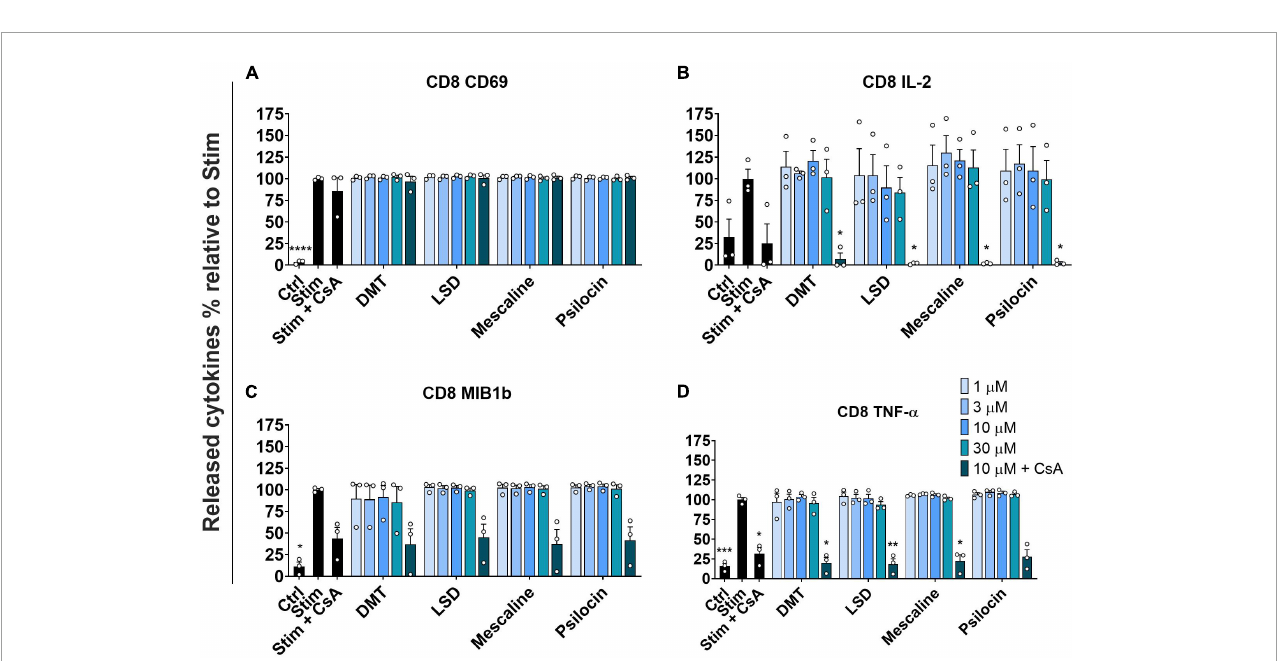
FIGURE2 Influence of classic psychedelics on (A) the activation (CD69) and function/mediator release in form of (B) IL-2 release, (C) CC-chemokine ligand 4 (MIB1b) release, and (D) TNF- α release of primary human CD8 + T cells. PBMCs were stimulated with anti-human CD3 and anti-human CD28 mAb (Stim) and incubated in the presence of medium alone (Neg Ctrl), different control substances, and psychedelic compounds for 48 h. PBMCs were re-stimulated with PMA and ionomycin for 4 h. Cyclosporine A (CsA) served as a control substance for cytokine release inhibition. Data are the mean ± SEM from three independent experiments. Data were analyzed by one-way ANOVA followed by Dunnett’s T3 multiple comparison test (**** P < 0.0001, *** P < 0.001, ** P < 0.01, * P < 0.05 when compared to stimulated cells without drug